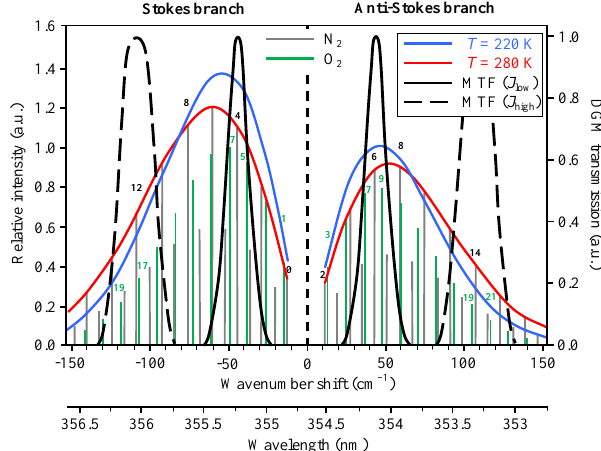
Figure 1. Equidistant PRR spectra of N 2 and O 2 linear molecules, schematic drawing of the IMCES lidar monochromator transmis- sion functions (MTF), and envelopes of N 2 PRR spectrum at differ- ent temperatures. The red and blue envelopes correspond to the tem- perature of 280 and 220K, respectively. The laser-beam wavelength is 354.67nm. The index over a spectral line denotes the rotational quantum number J of the initial state of the transition. The spectral line number and number J are the same for the Stokes branch. All PRR line intensities are normalized to the intensity of N 2 PRR line with J = 6 of the anti-Stokes branch at T =